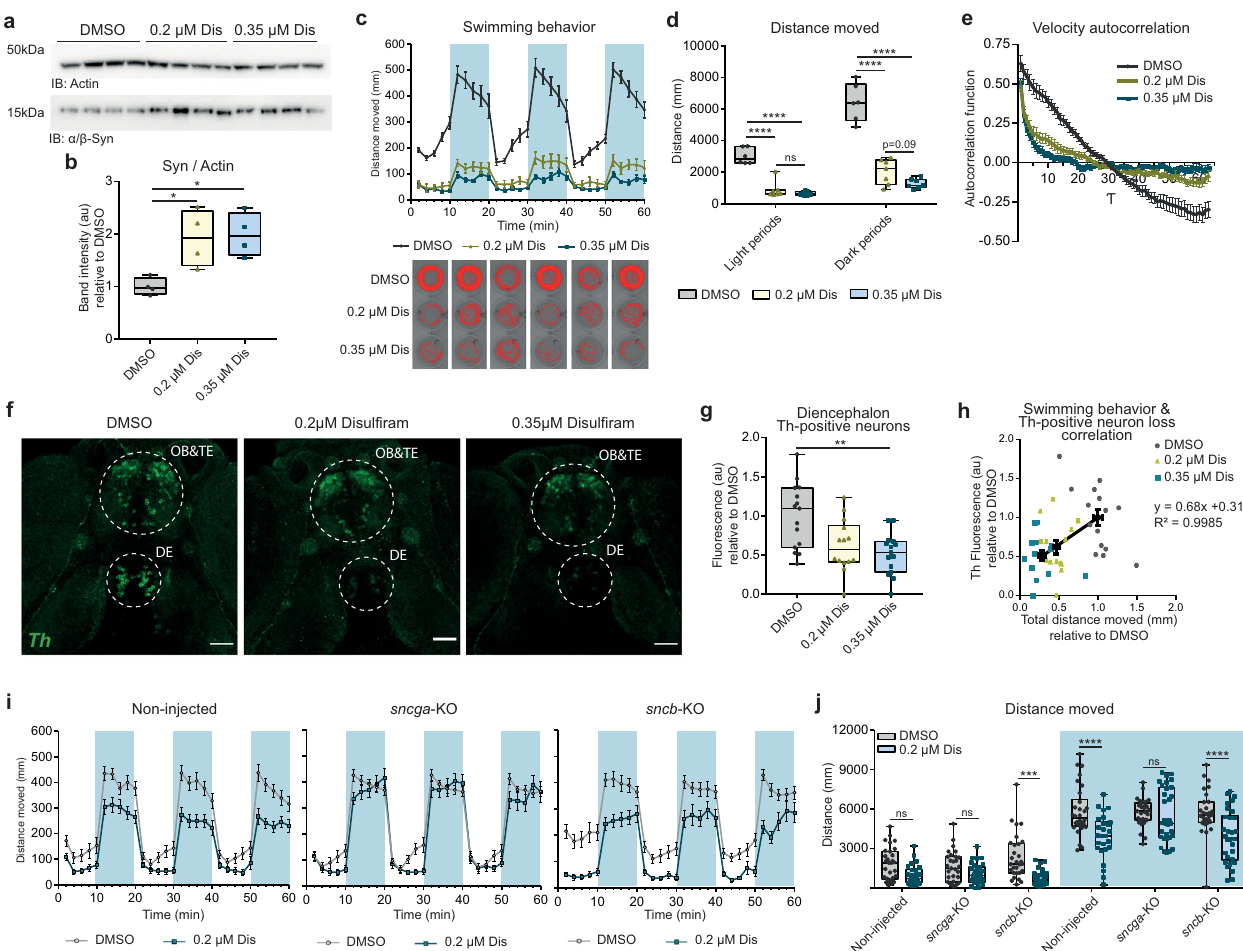
Fig. 8 In vivo zebra fi sh model of impaired DOPAL detoxi fi cation. Biochemical, behavioral, and histological analysis in DMSO-, 0.2 µM Dis-, and 0.35 µM Dis-treated wild-type zebra fi sh larvae from 2 dpf to 5 dpf. a Immunoblot of Synuclein in lysates of zebra fi sh larvae heads, and b relative quanti fi cation. Data from four biological replicates are normalized to the mean value of the DMSO-treated samples and analyzed by Kruskall – Wallis test with Dunn ’ s multiple comparison test (* p < 0.05). c Time-course of the distance moved during the light-dark locomotion test acquired at DanioVision ™ . In the graph, the blue areas indicate the three dark stimuli of 10 min each. Data are presented as mean ± SEM from seven independent experiments. In the bottom part, representative tracks for each 10-min segment and each treatment are displayed. d Quanti fi cation of the total distance moved during the three light periods and the three dark periods. Data are analyzed by Two-way ANOVA with Sidak ’ s multiple comparison test (**** p < 0.0001; interaction **** p < 0.0001, dark stimulus **** p < 0.0001, Disul fi ram treatment **** p < 0.0001, subjects matching ** p < 0.01). e Autocorrelation function of the time-course of velocity (10 second-bin) of movement. Data are presented as mean ± SEM from three independent experiments (DMSO: 15 larvae; 0.2 µM Dis: 14 larvae; 0.35 µM Dis: 14 larvae). f Immunostaining with the anti-TH antibody, which displays the dopaminergic neuron clusters OB&TE and DE. Scale bar: 50 µM. g Quanti fi cation of TH fl uorescence signal in the dopaminergic neuron cluster in the DE. Data from three independent experiments pooled together and analyzed by Kruskall – Wallis non-parametric test with Dunn ’ s multiple comparison test (** p < 0.01). h Correlation of swimming behavior of single larvae with the relative TH- fl uorescence intensity in the DE neuron cluster. Data are collected from three independent experiments (DMSO: 15 larvae; 0.2 µM Dis: 14 larvae; 0.35 µM Dis: 14 larvae), where both parameters are normalized to the mean value of the DMSO-treated sample, and the black dots represent the mean values (±SEM). i Time-course of the distance moved by DMSO- and 0.2 µM Dis- treated zebra fi sh larvae during the light-dark locomotion test. The three graphs correspond to the swimming behavior of non-injected larvae, and larvae injected with sgRNAs-Cas9 complexes to generate sncga -KO or sncb -KO F0. j Relative quanti fi cation of the total distance moved during the three light periods and the three dark periods (indicated by the light blue quadrant) of the swimming behavior analysis. Data from three independent experiments are analyzed by Two-way ANOVA with Sidak ’ s multiple comparison test (*** p < 0.001, **** p < 0.0001). b , d , g , j Data are displayed as box and whiskers plot showing the minimum and maximum points (whiskers), the fi rst quartile, median and third quartile (box lines). c , e , i Data are shown as mean ± SEM each